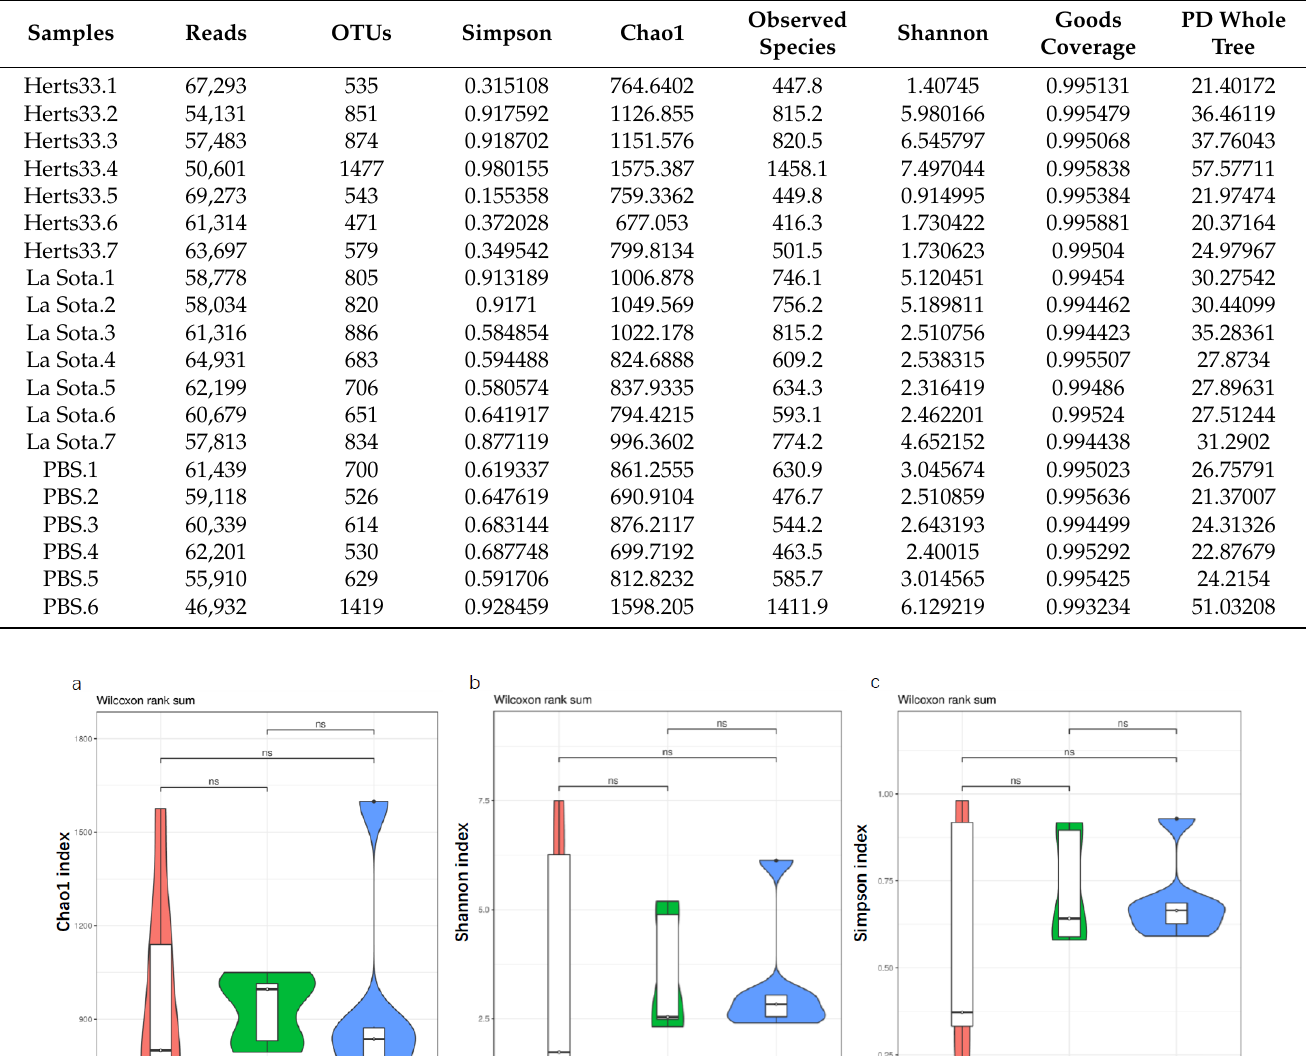
Table 1. The estimators of sequence diversity and richness.